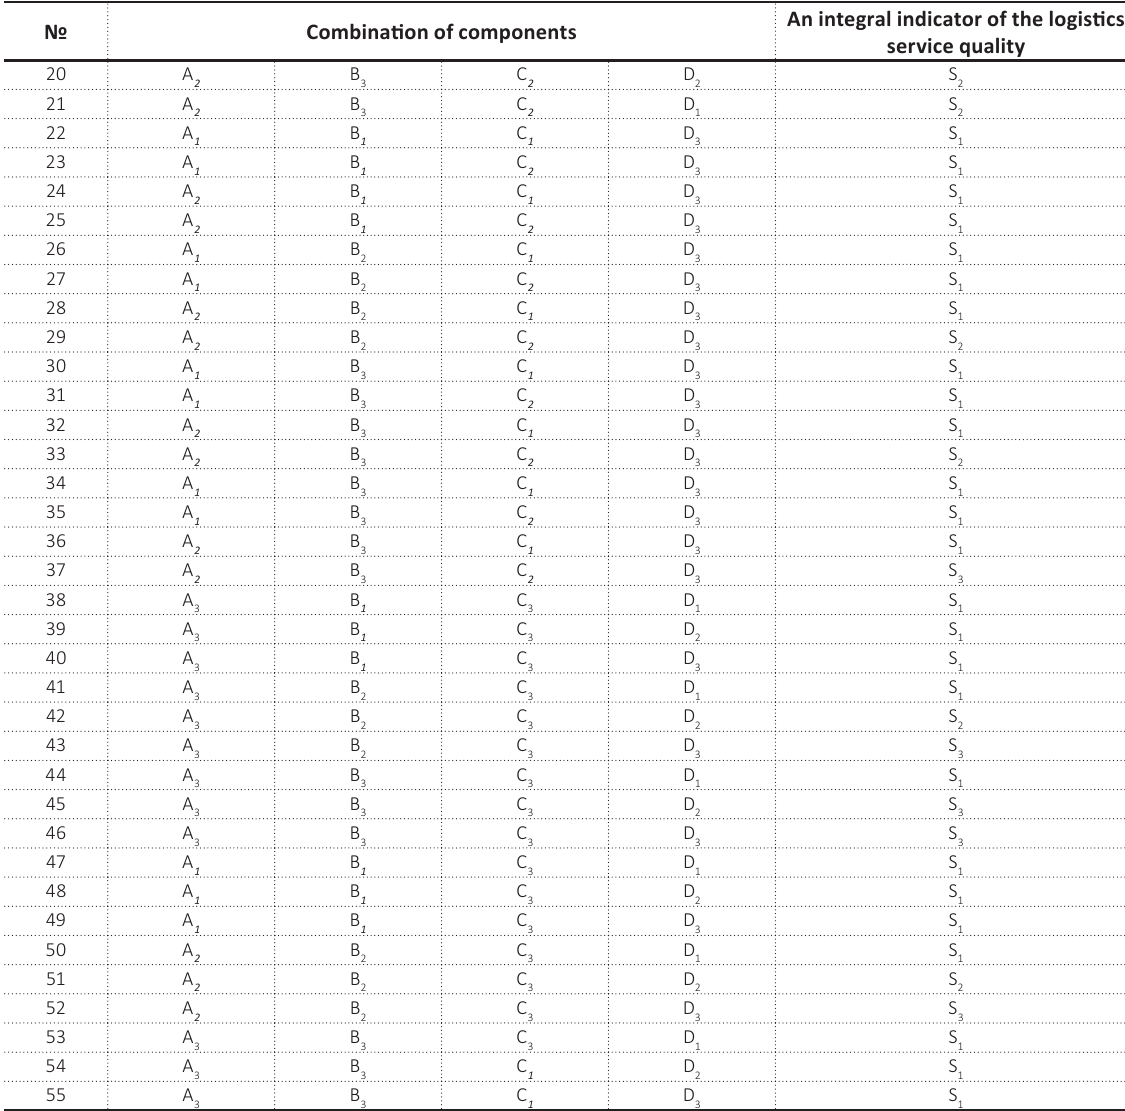
Table A9 (cont.). Rules for forming an assessment of the quality of logistics service of logistics operators/providers